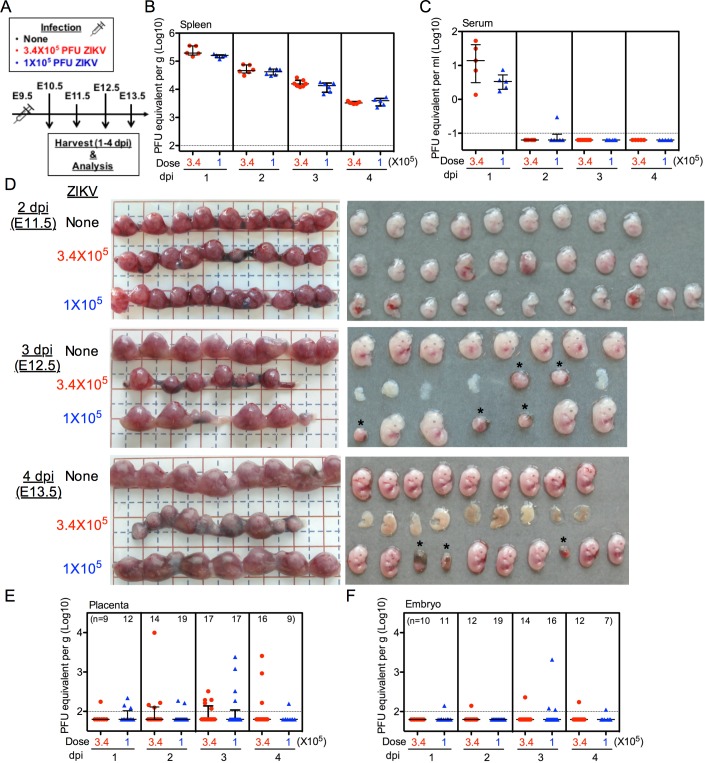
A range of fetal abnormalities present early, and correspond to dosing but not viral RNA level.Pregnant dams at E9.5 were infected with 3.4 or 1 × 105 PFU of ZIKV by intravenous route, and sacrificed at 1 through 4 dpi. Control mice were left uninfected. (A) Scheme of infection. (B and C) ZIKV RNA levels in the spleen (B) or serum (C) of ZIKV-infected dams. (D) Representative images of uteri and embryos at 2–4 dpi. Asterisk indicates the placental residues of demised/resorbed embryos. Fetal abnormalities were observed as early as 2 dpi, with further deterioration over the next 24–48 h to severe fetal demise. (E and F) ZIKV RNA levels in the placenta (E) or whole embryo (F). (B, C, E, and F) ZIKV RNA levels were measured by quantitative real-time PCR. Dotted line depicts the limit of detection. Data shown are median with interquartile range. Data for all panels are pooled from 2 independent experiments.